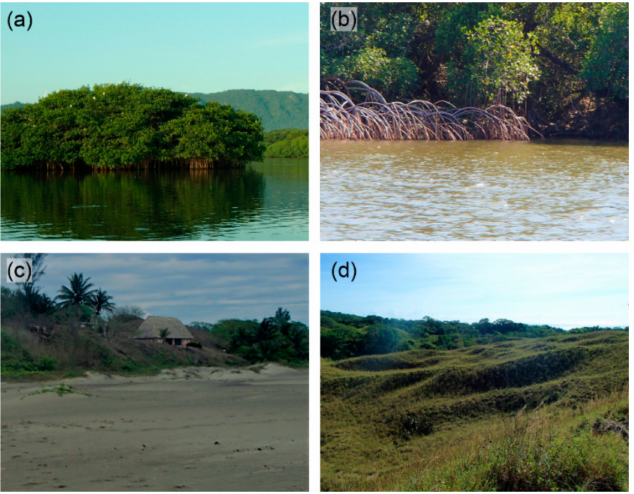
Figure 3. La Mancha: red mangrove in the ( a ) lagoon and ( b ) lagoon margins ( Rhizophora mangle ); ( c ) beach and coastal dunes; ( d ) vegetated dune